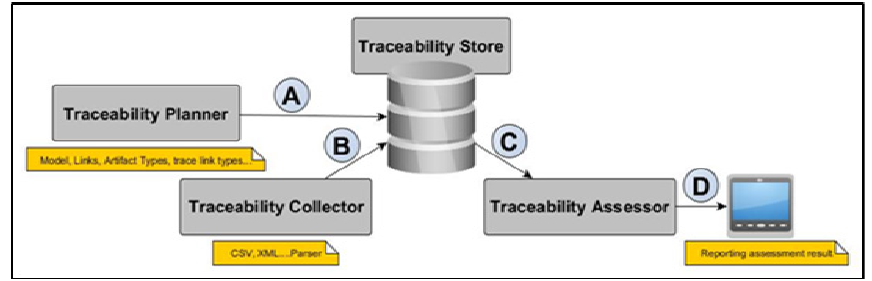
Fig. 1. Software Traceability Assessment Approach